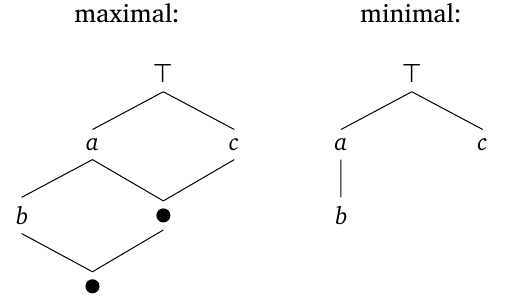
Examples of a maximal and a minimal model of type